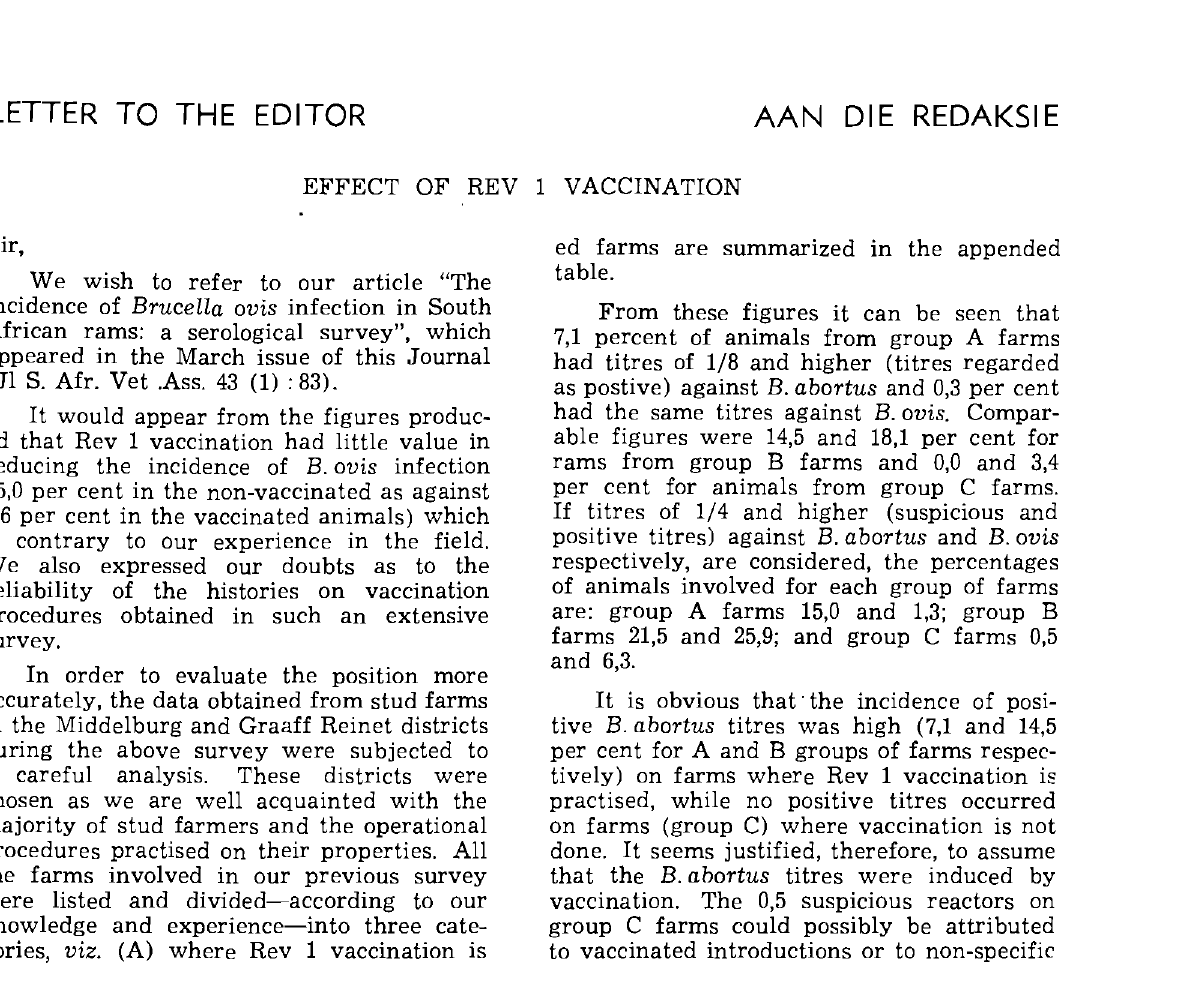
Table: COMPARISON OF CF TITRES AGAINST B. ABORTUS AND B. OVIS OF SERA FROM RAMS ACCORDING TO REV I VACCINATION PRACTICE B. abortus